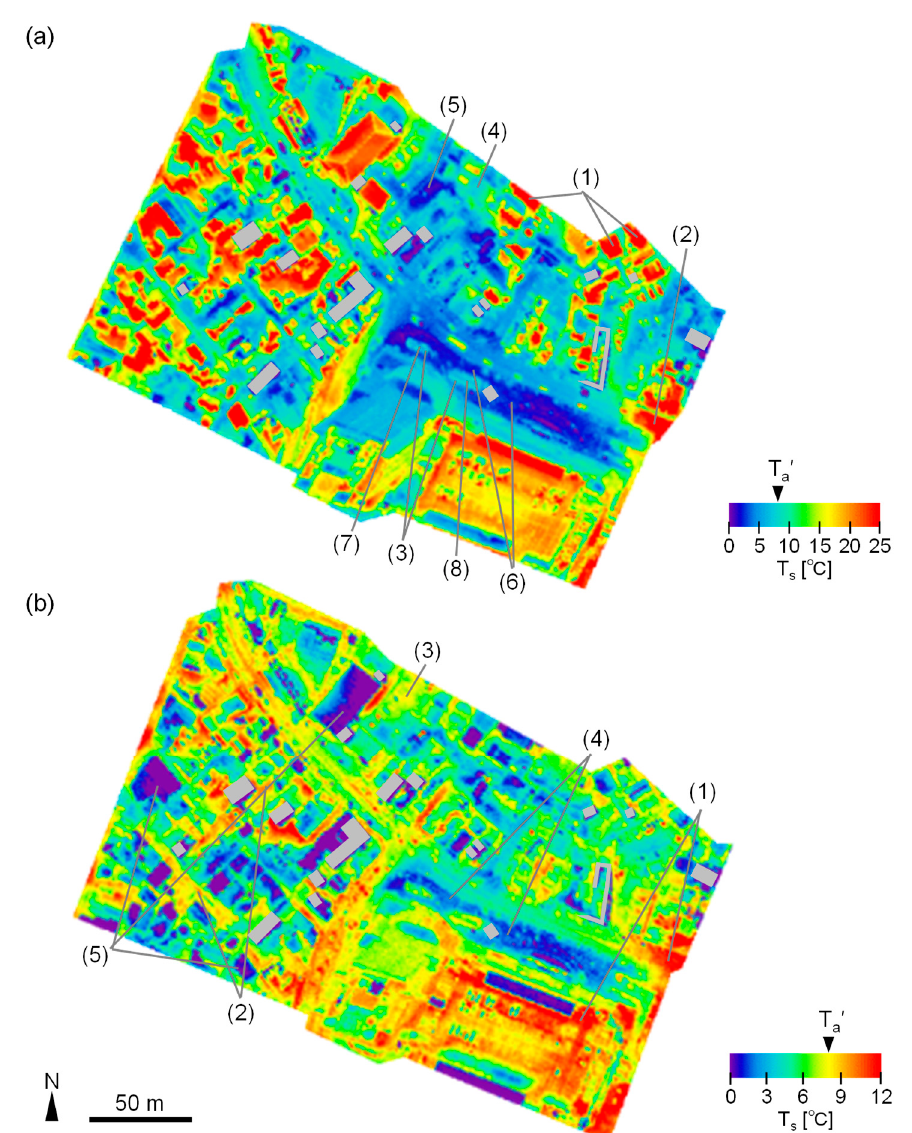
Figure 3. Distribution of remotely sensed T s : ( a ) daytime and ( b ) after sunset. The numbers in the figure indicate specific points discussed in the main text. Representative air temperature (T a ′ ) is depicted for each time period. Gray masks indicate materials with low emissivity where there is a possibility that the calculated T s differs significantly from the actual T s .